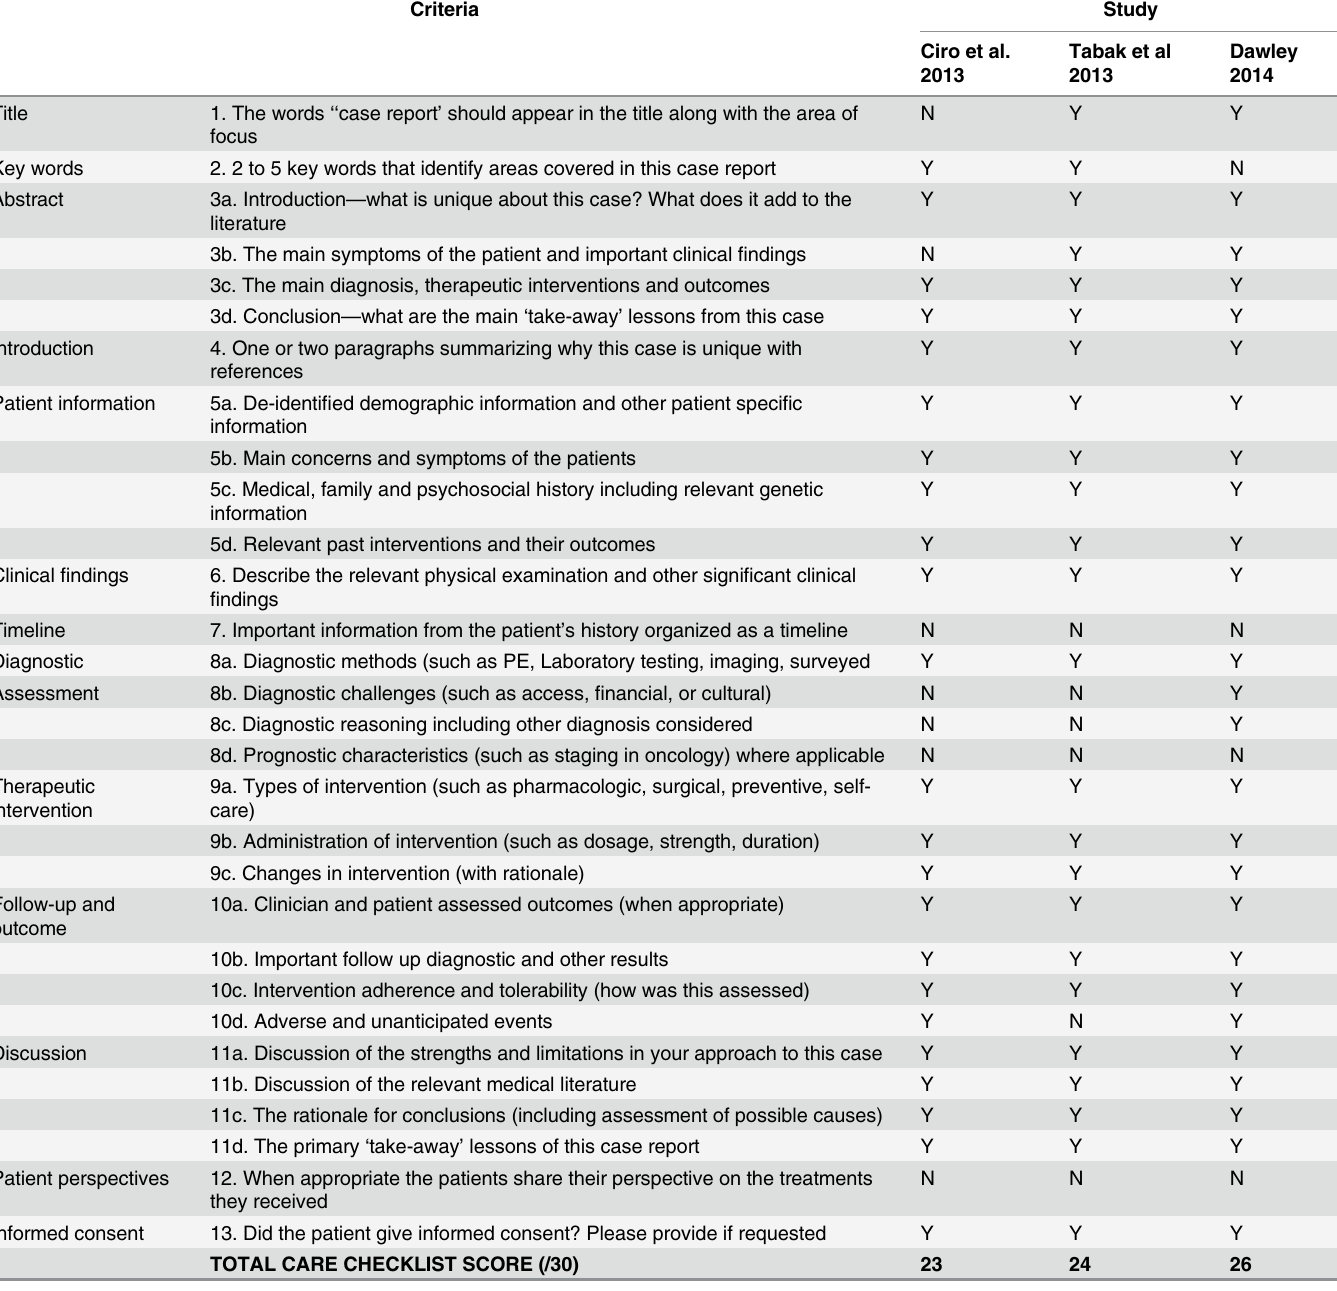
Table 2. CARE Criteria: Case report